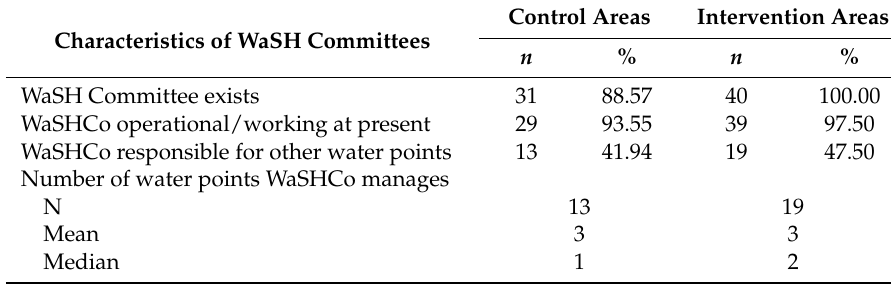
Table 4. Characterization of WaSHCos in intervention and control